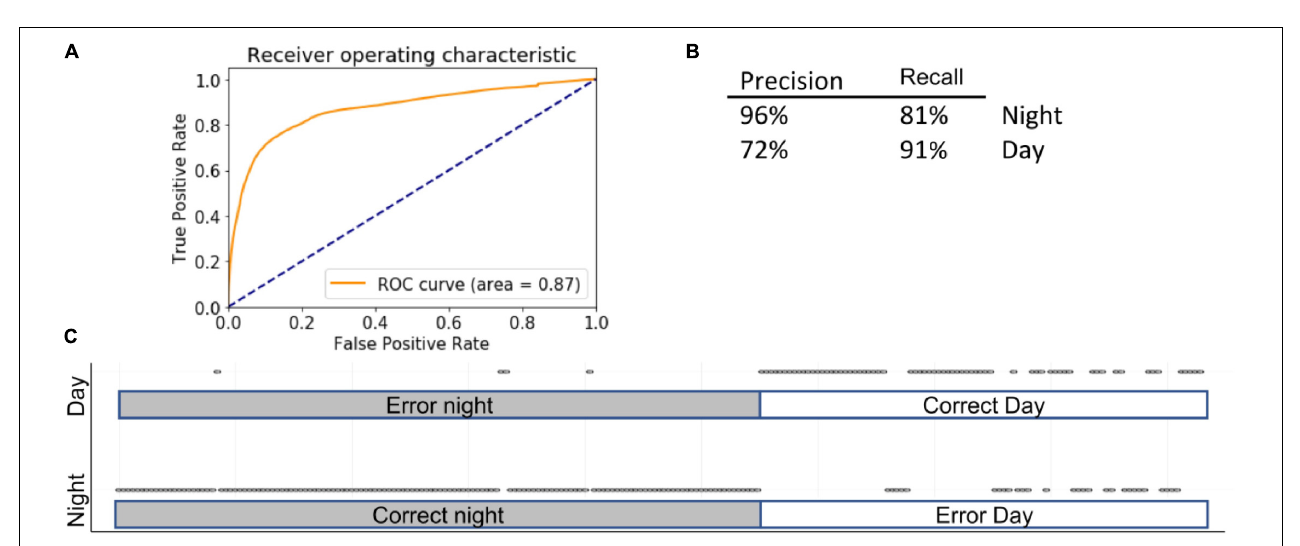
FIGURE 4 | Summary of RF. Inserts show ROC (A) curve, precision summary (B) , and graphical representation of the ratio of true positives to false positives (C) . Open circles represent predictions. The majority of predictions are correct, and therefore circles overlap into apparent lines. Dots above marked bars represent incorrect predictions.